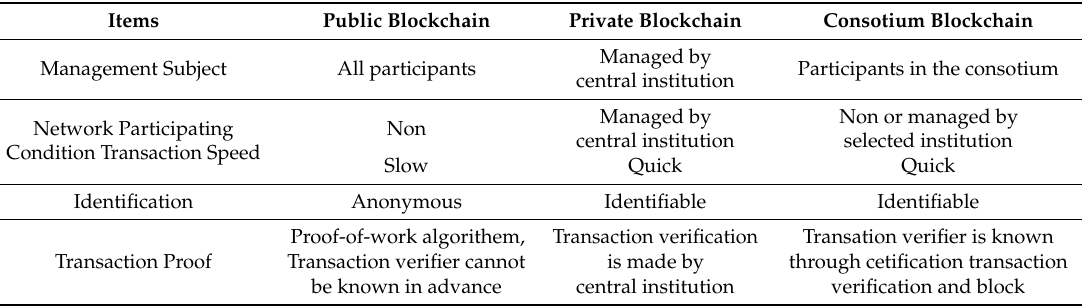
Table 1. Type of Blockchain.